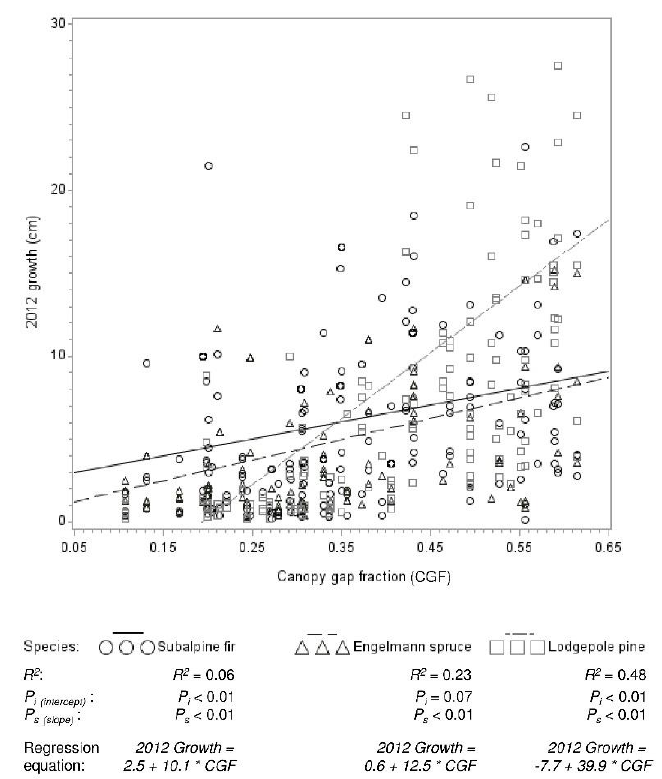
Figure 4. Average 2012 leader growth of lodgepole pine, Engelmann spruce, and subalpine fir (trees <1.4 m tall) under high and moderate levels of overstory mortality. Stars indicate significant growth differences between the mortality levels (α = 0.05). Lines show standard error of the mean.